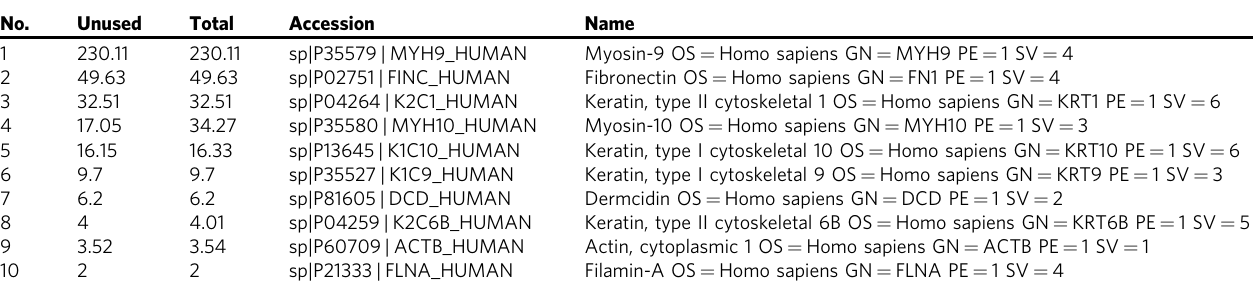
Table 3 Top ten proteins detected on mass spectroscopy from fi bronectin pull down.